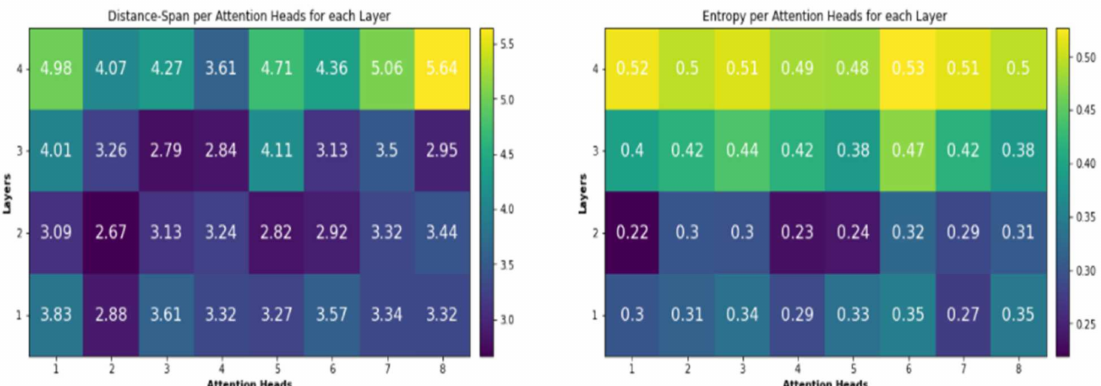
Figure 7. Variation of mean attention distance span and attention distribution entropy with respect to the encoding layers and the attention heads for the suggested model.